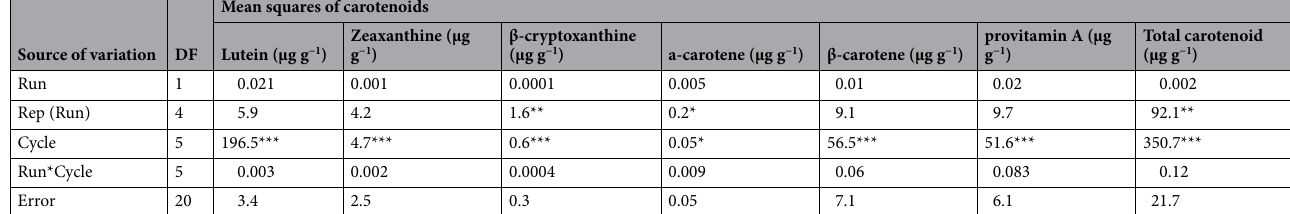
Table 2. Mean squares from analysis of variance for pro-vitamin A and other carotenoids of HGA and HGB populations improved through marker assisted recurrent selection. *, **, *** = Significant at P < 0.05, P < 0.01, and P < 0.001,